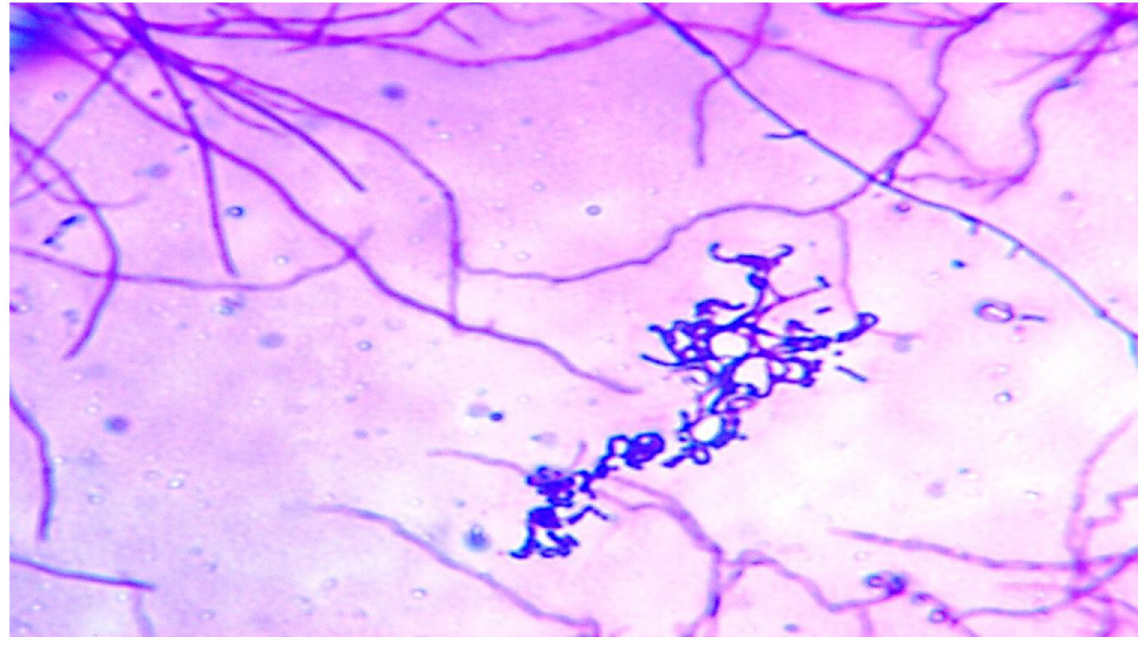
Fig 2. Morphological characters of Streptomyces sp. isolates according to Gram staining.